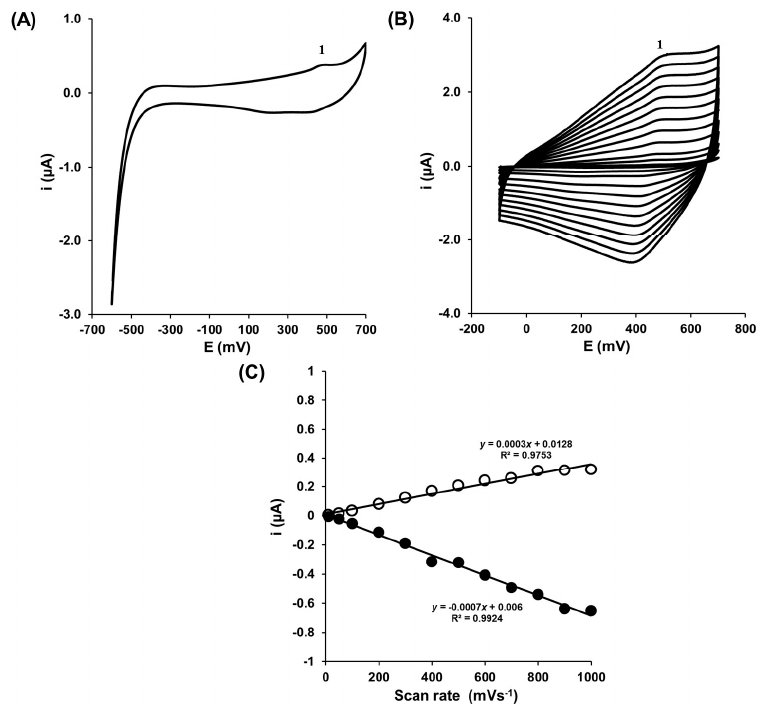
Figure 3. ( A ) Representative cyclic voltammogram recorded for gold electrode modified with HSCX- COOH/MET in the presence of 0.1 mM DA. Scan rate 100 mV s − 1 , potential range from −